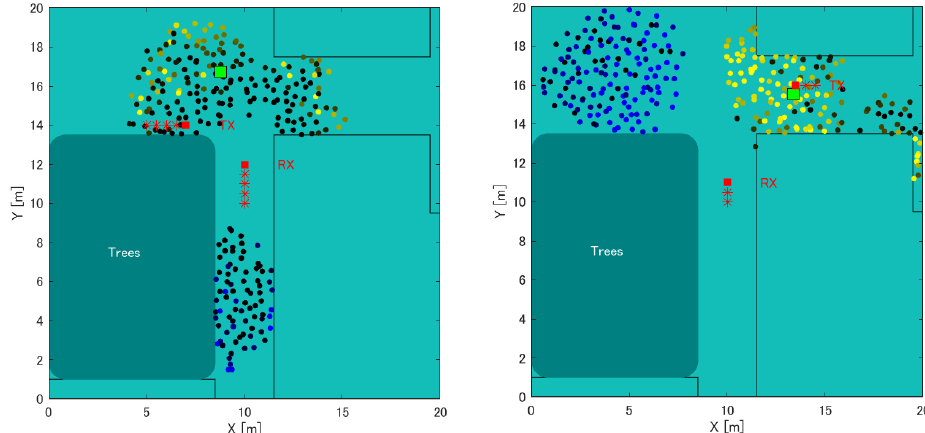
Figure 20. Position estimation results of the actual measurement when Tx is to the left of Rx and moving. Left: Tx of left direction. Right: Tx of right direction.